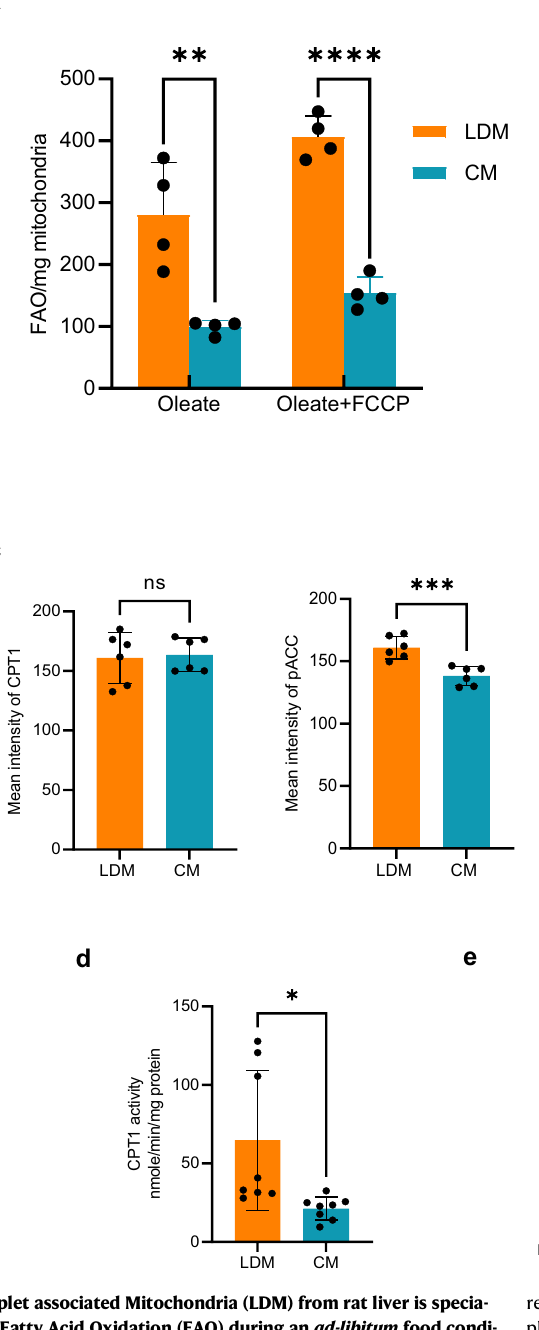
representative Western blot ( n =6) that was probed with antibodies against CPT1, phosphorylated ACC2 (pACC2), ACC2, and glutamate dehydrogenase (GDH) as a mitochondrial loading control. c Densitometric analysis of the western blot ( n =6) is shown in Fig. 3b for isolated LDM and CM samples from the liver. Data are presented asmeanvalues±SD. Signi fi cance was calculatedby two tailedun-paired Student t -test. ***p =0.0008, *p =0.028. d Quanti fi cation of CPT1 activity in LDM andCM( n =8).Dataarepresentedasmeanvalues±SD.Signi fi cancewascalculated bytwotailedun-pairedStudent t -test. *p =0.016. e APonceauSstainofthewestern blot (b) is shown here for total protein